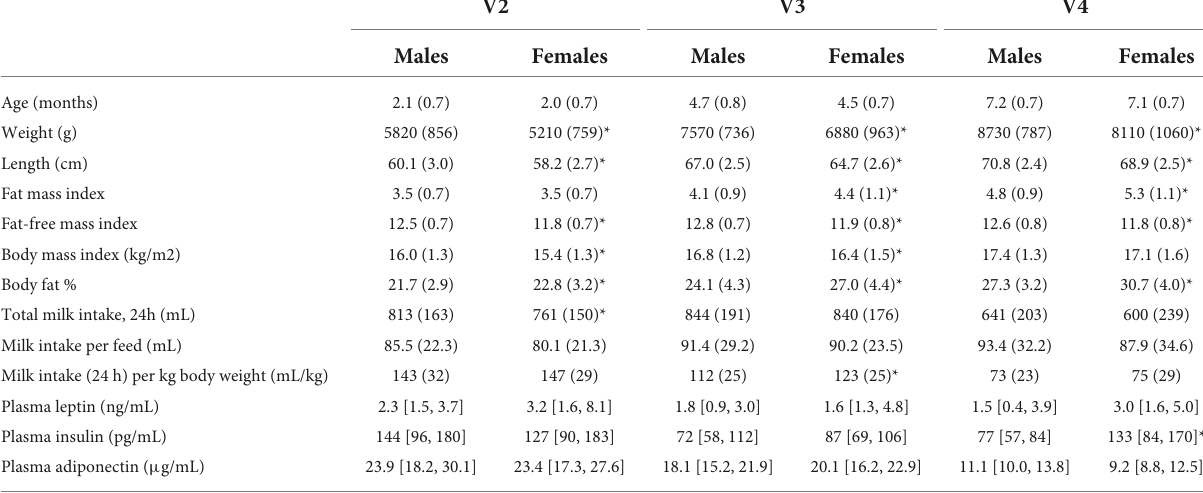
TABLE 2B Infant anthropometry, body composition, milk intake and plasma hormone concentrations at the three postpartum